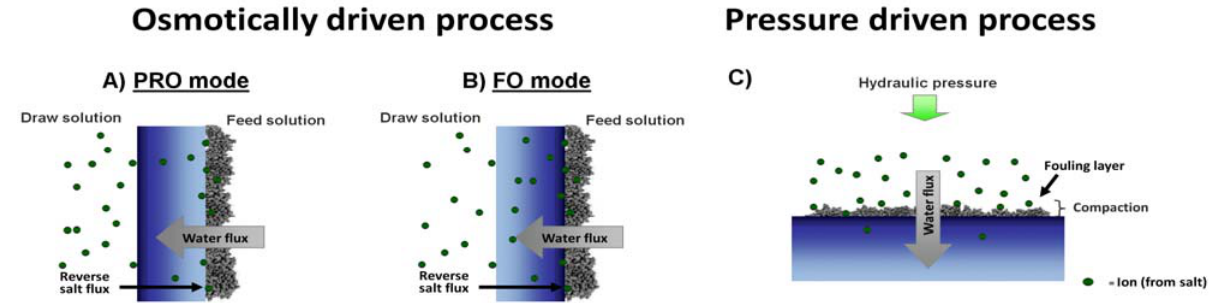
membrane processes. ( A ) Fouling in PRO mode; ( B ) fouling in FO mode and ( C ) fouling in